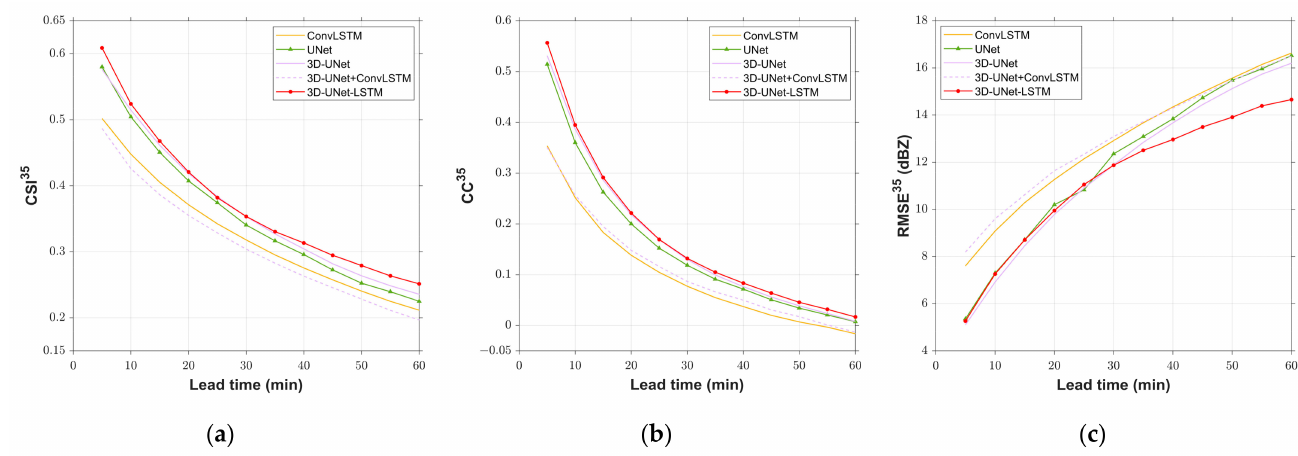
Figure 4. The ( a ) CSI , ( b ) CC and ( c ) RMSE curves at the 35 dBZ threshold against different lead times for the evaluation of the model